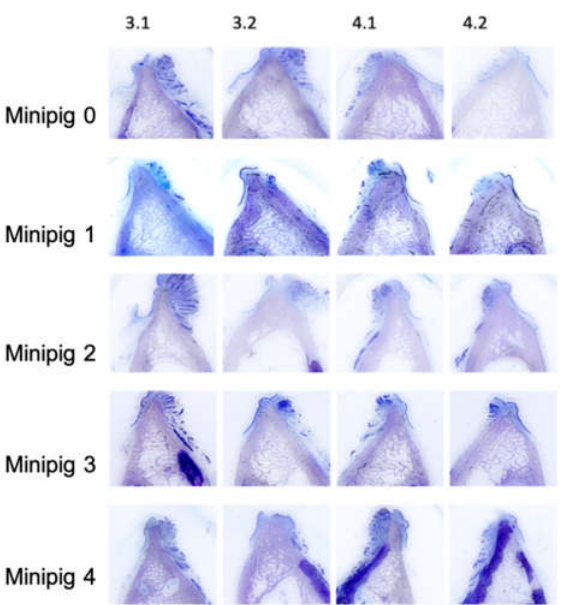
Figure 3. Overview of the thin-section histologies of all former extraction sockets, two premolars in the mandible on both sides (staining: toluidine blue; magnification: 2×).